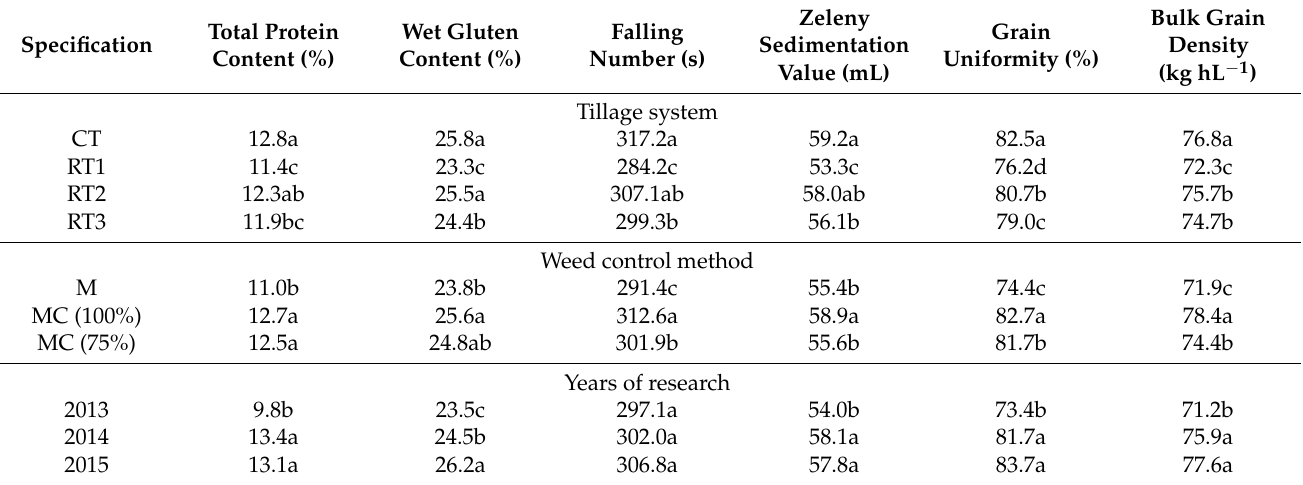
Table 4. Selected quality features of spelt wheat grain depending on the tillage systems, weed control methods (mean for 2013–2015), and years of research.